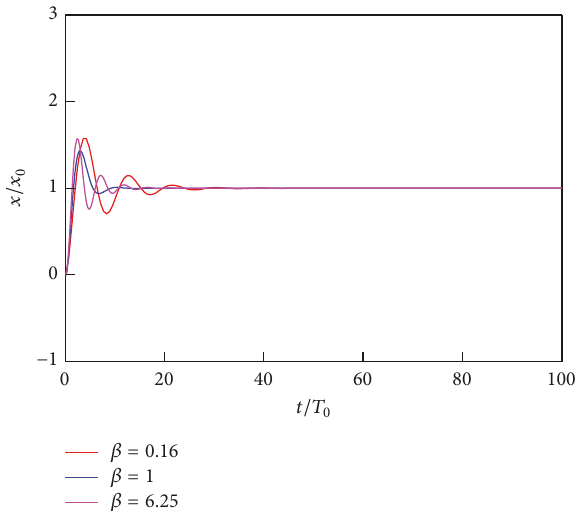
Figure 22: Response in the time domain (𝛼 = 2, 𝛽 = 0.16, 1,6.25) . 𝜓 = 𝑠/𝜔 𝑠 = 𝑗𝜔 , and, defining Ω = 𝜔/𝜔 0 ,